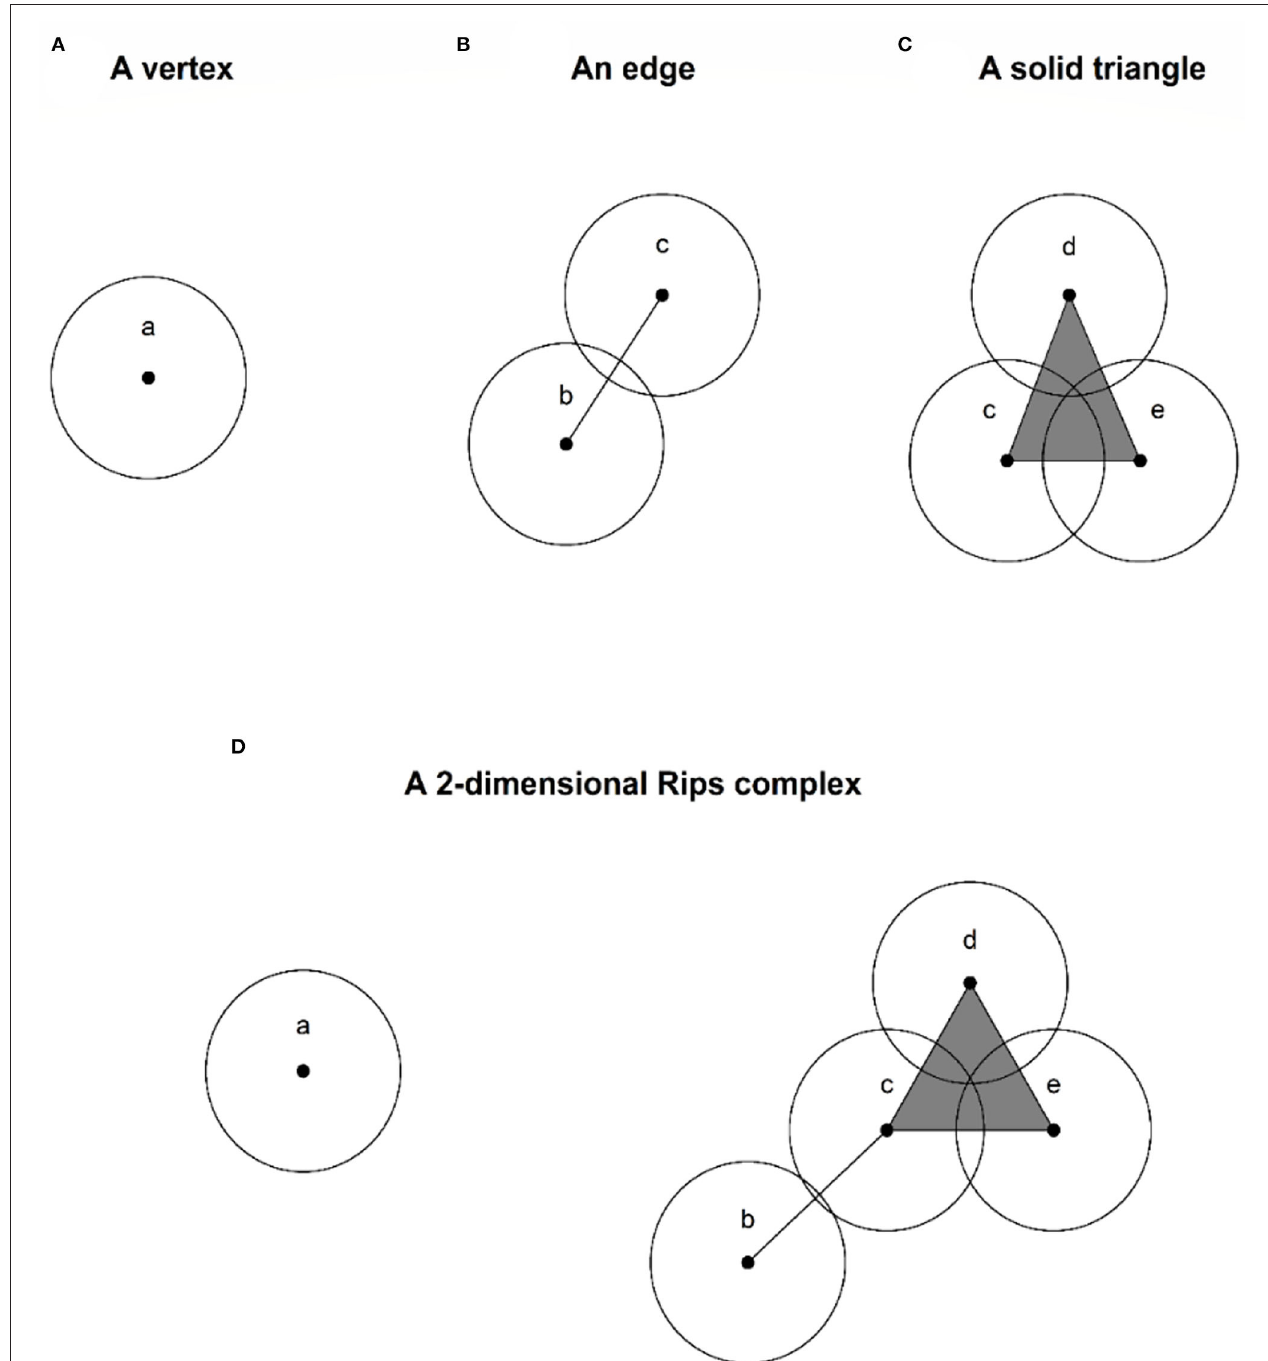
FIGURE 1 | (A,B) are 0-simplex, 1-simplex, 2-simplex, and a two-dimensional Rips complex, respectively.